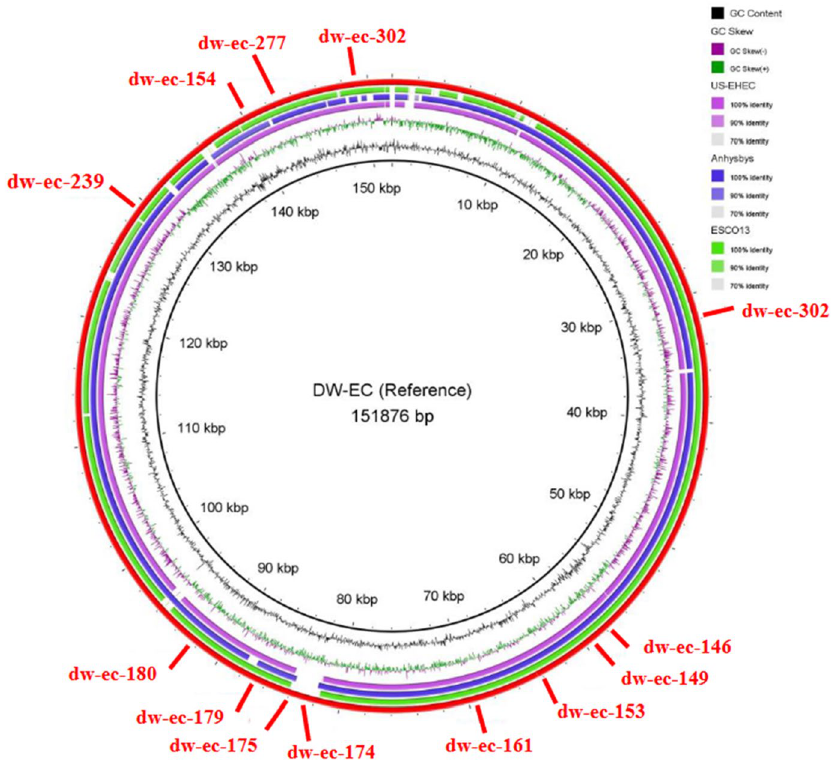
Figure 3. Comparative genomic analysis of DW-EC and the other bacteriophages. The inner circle is the DW-EC genome as a reference. Others included US-EHEC (purple), anhysbys (blue), ESCO13 (green), and DW-EC annotation (red). Colored rings showed similarity between each